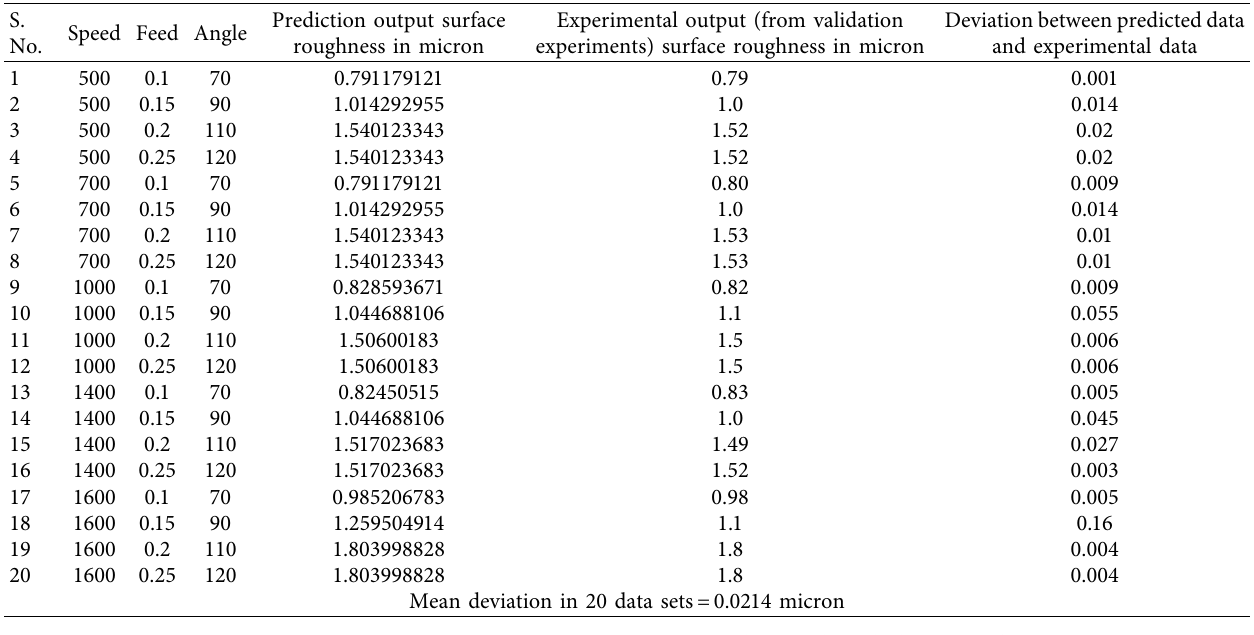
Table 5: XGBoost regressor predicted values and actual